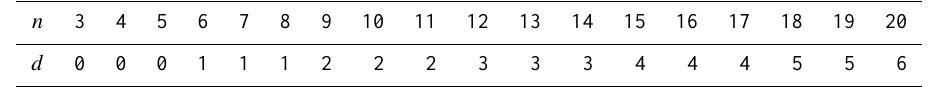
Table B1. The maximum number of permissible disagreeing proxies ( d ) for a given number of total proxies ( n ) found within a search radius to pass the sign test.